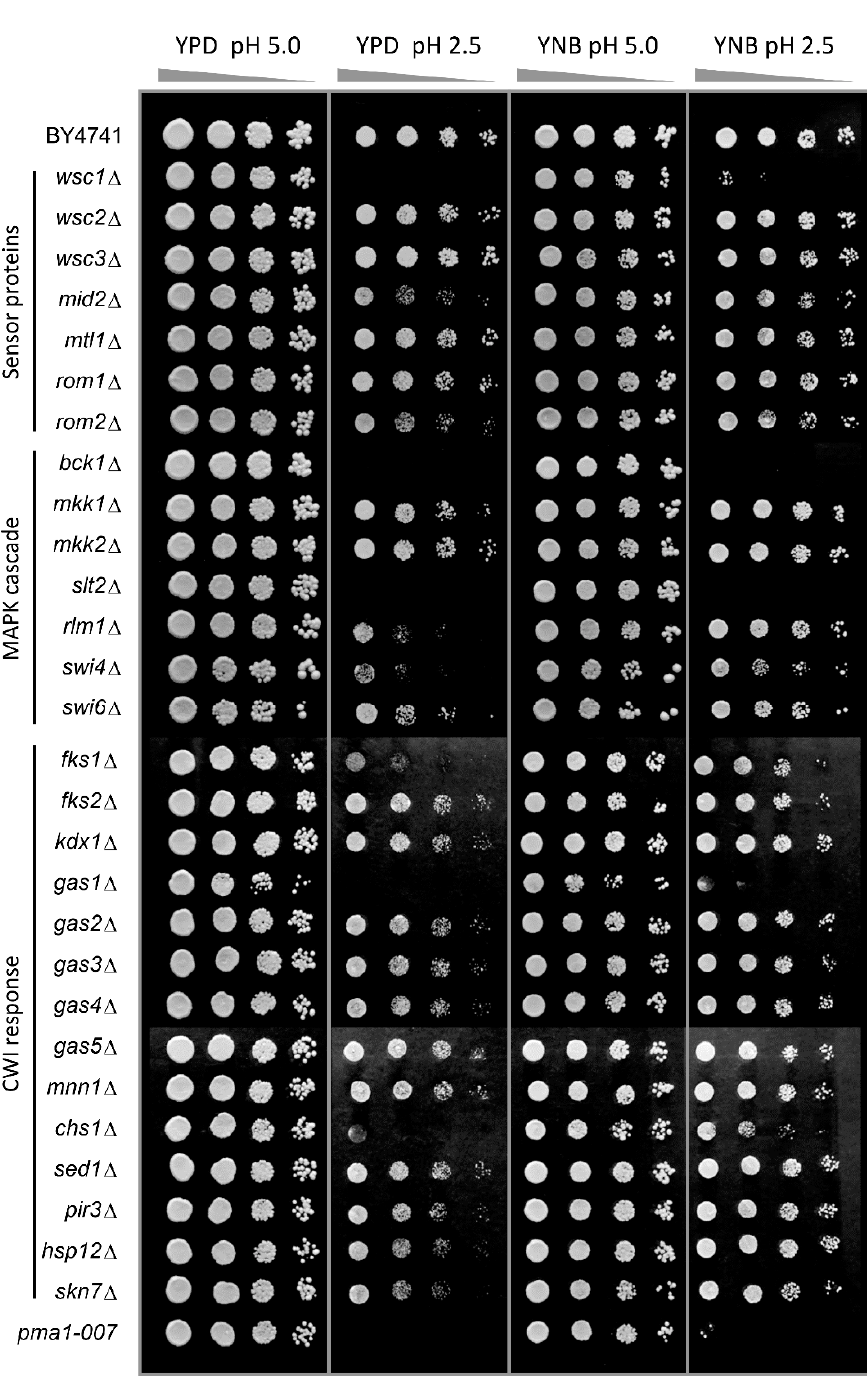
Figure 1. Screening for low pH ex sensitive mutants involved in cell wall signalling and biosynthesis. S. cerevisiae BY4741 wild type strain and isogenic mutants were cultivated in YPD medium and serial dilutions (1/10) of yeast cultures were spotted on YPD or YNB agar media adjusted to pH 5.0 or 2.5 with sulphuric acid. Plates were incubated for two days at 30 °C. The mutant pma1 ‐ 007 with reduced activity of plasma membrane H + ‐ ATPase pump was used as no ‐ growth reference at low pH.